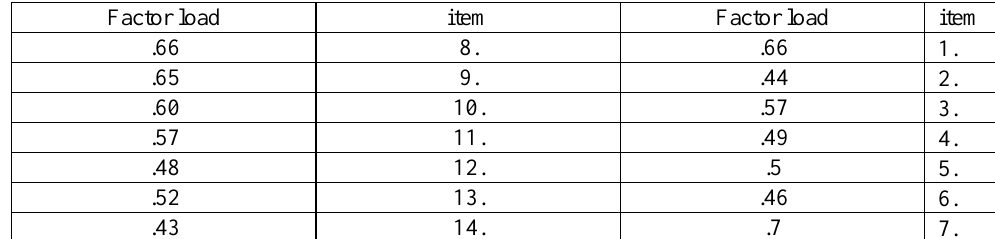
Table 1. Confirmatory factor analysis of optimism and pessimism